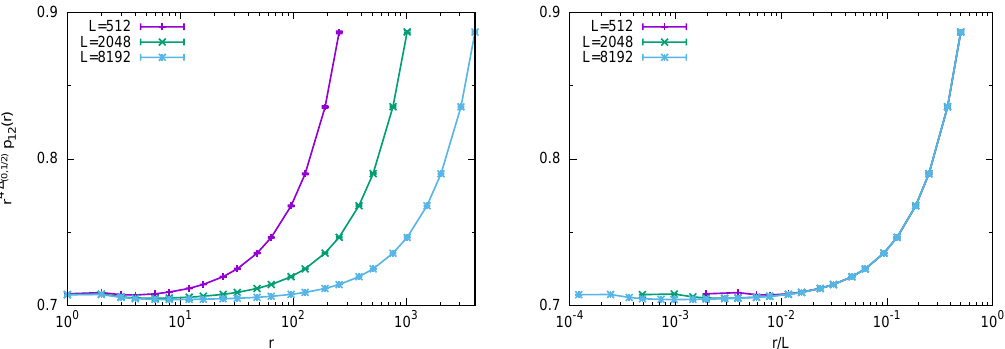
Figure A.2: Two-point connectivity of the Ising model Q = 2 for three values of the lattice size L . The plots show r